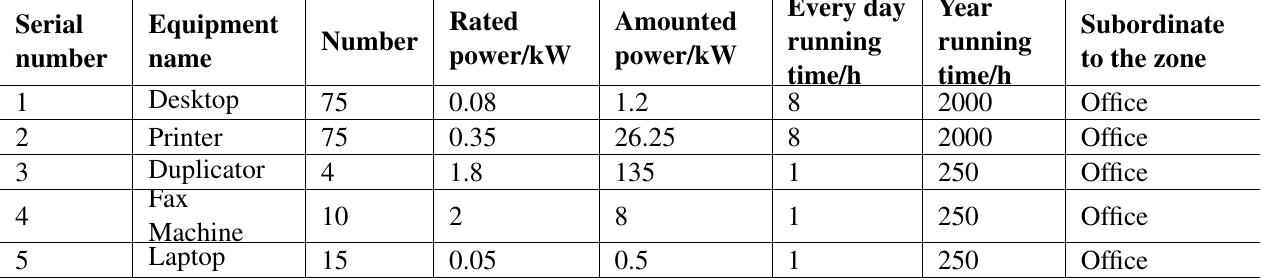
Table 2 Indoor office equipment and household